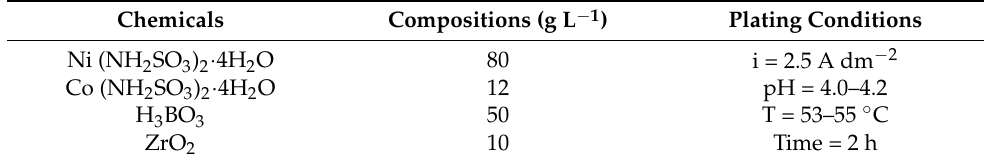
Table 1. The bath compositions and plating parameters.